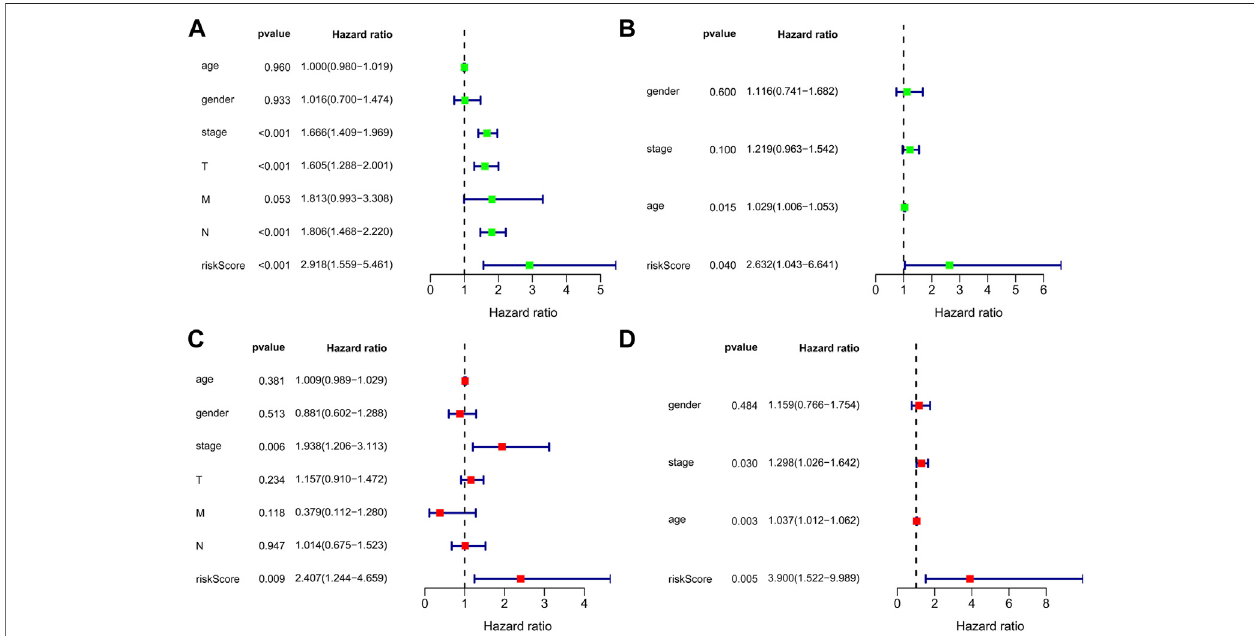
FIGURE 5 | Forest plot of the univariate and multivariate Cox regression analyses in NSCLC. Forest plot of the univariate Cox regression analysis of TCGA cohort (A) and GEO cohort (B) . Forest plot of the multivariate Cox regression analysis of TCGA cohort (C) and GEO cohort (D) .